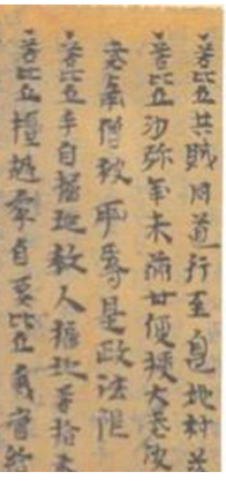
Figure 4. Ten Chants of Bhikkhu Precepts.